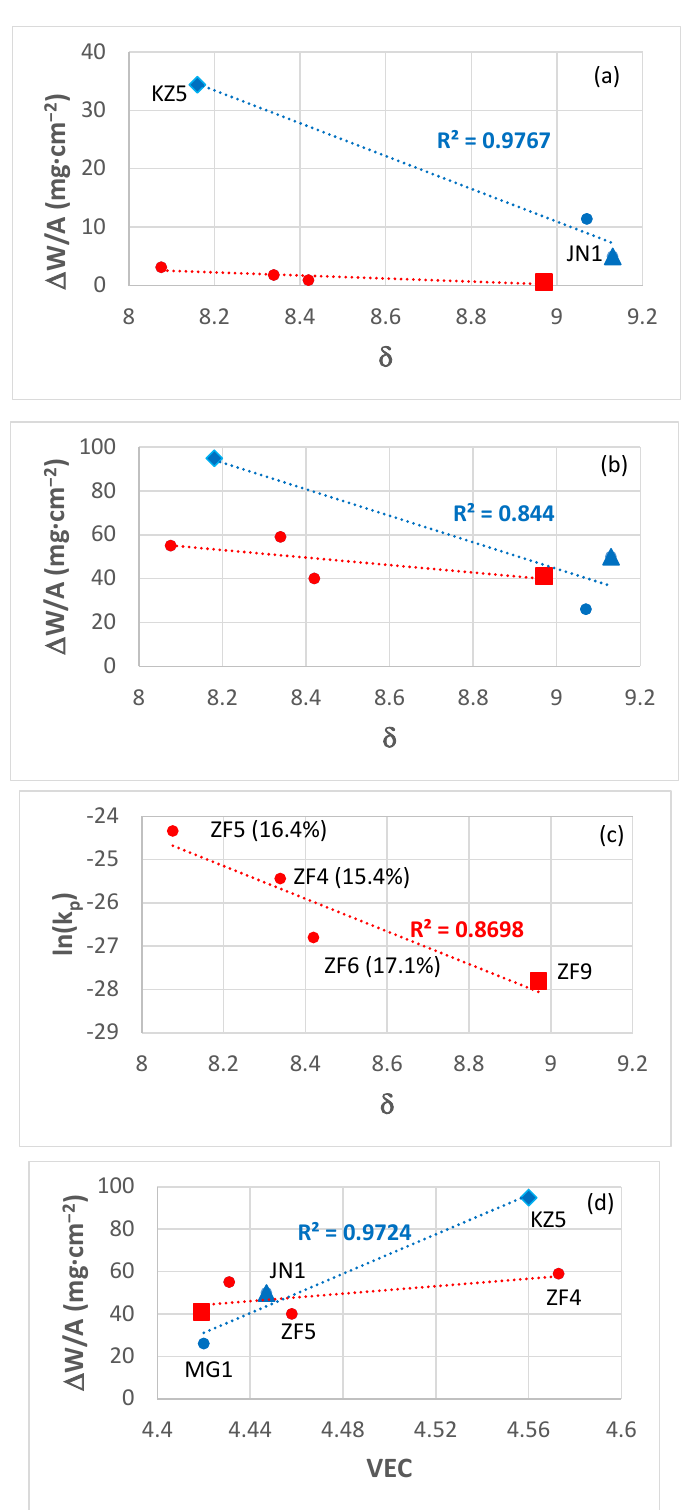
Figure 14. Plots of ∆ W/A versus the parameters δ and VEC for alloys with/out Ge addition. Data in ( a ) and ( c ) for 800 °C and in ( b ) and ( d ) for 1200 °C. In ( a ), ( b ), and ( d ) data for the alloys KZ5 (Nb-24Ti-18Si-5Al-5Cr [59]), MG1 (Nb-24Ti-18Si-5Al-5Hf [60]) and JN1 (Nb-24Ti-5Al-5Cr-5Hf [60]) is shown in blue. In all figures, the HEA (ZF9) is shown by the red square. The vol % Nb ss in the alloys ZF4, ZF5, and ZF6 in the bulk of their buttons, from which the oxidation specimens were selected, is shown in ( c ). Direct comparison of the alloy ZF9 with the scarce data about the oxidation of RM HEAs is not possible because (i) oxidation has been evaluated at different temperature(s), (ii) isothermal oxidation was evaluated in some studies and cycling oxidation in others, (iii) different atmosphere and duration were used, (iv) different alloying elements were present in the constitution of the HEAs, and (v) the HEAs had different microstructures.